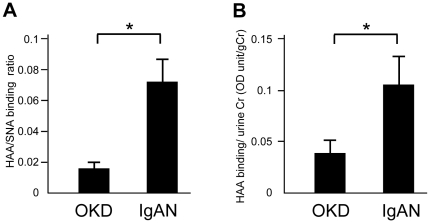
The urinary HAA/SNA binding ratio in patients with IgAN and other kidney diseases.The HAA/SNA ratios were determined by the HAA or SNA lectin binding assays using anti-IgA antibody-coated plates. The HAA/SNA ratio was higher in IgAN patients compared to patients with other kidney diseases (OKD) (P<0.05) (A). The level of HAA binding corrected for the urinary creatinine concentration was also higher in IgAN patients compared to patients with OKD (P<0.05) (B). Each column consists of the means ± SE. OKD, n = 142; IgAN, n = 78 *P<0.05.